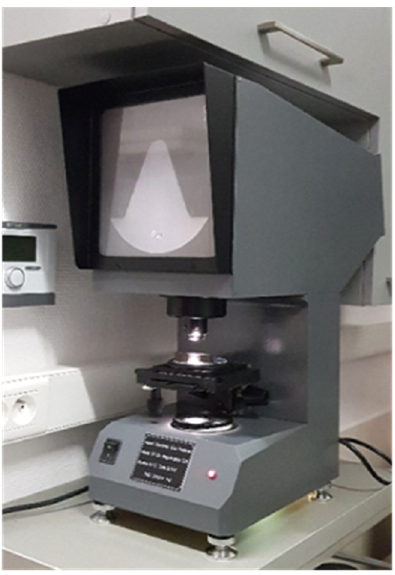
Figure 7. The notch profile projector XT-50 used during the tests to verify whether the notch size tolerance criteria have been observed.